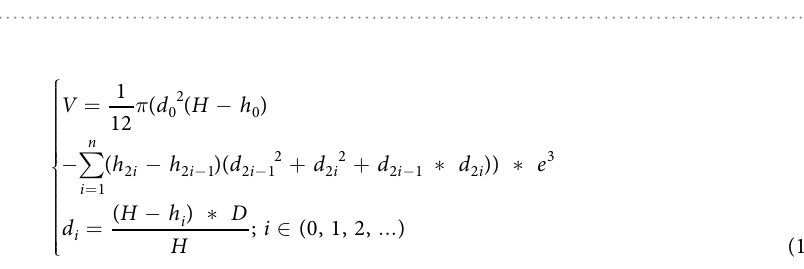
Table 1. Fixed value stability test results